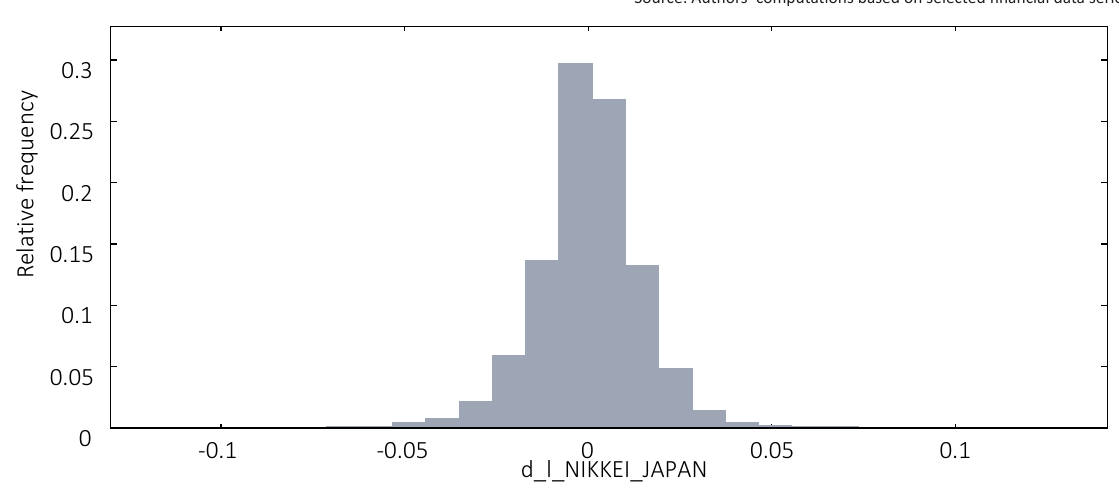
Figure 3. Evidence on autocorrelation and partial autocorrelation tested for NIKKEI 225 index during the sample period